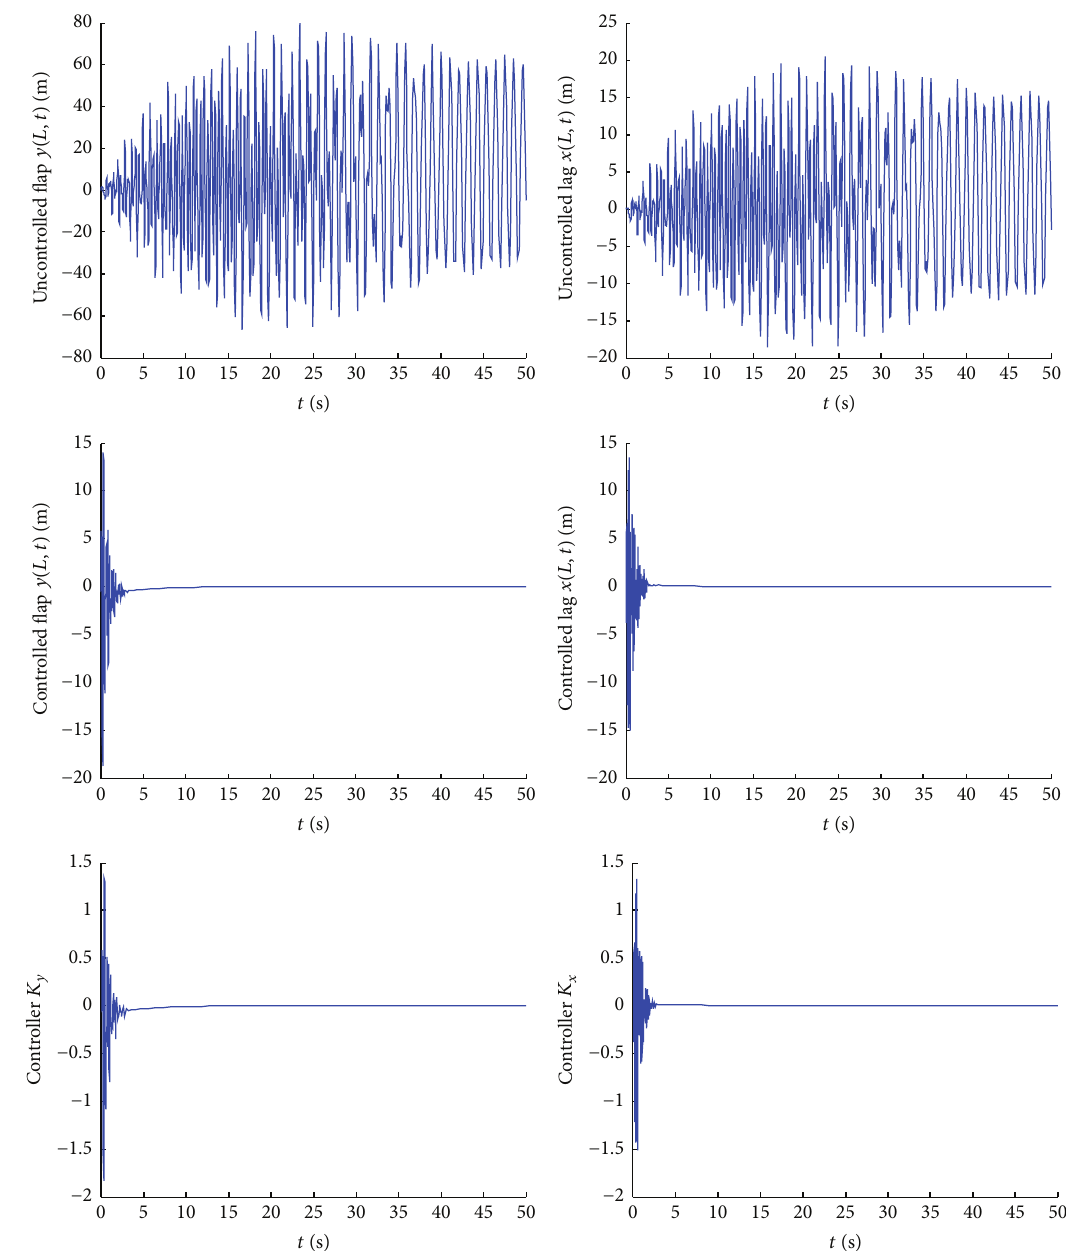
Figure 6: Both uncontrolled and controlled responses of flap/lag motions under 𝑈 = 15 m/s, with controller values attached.